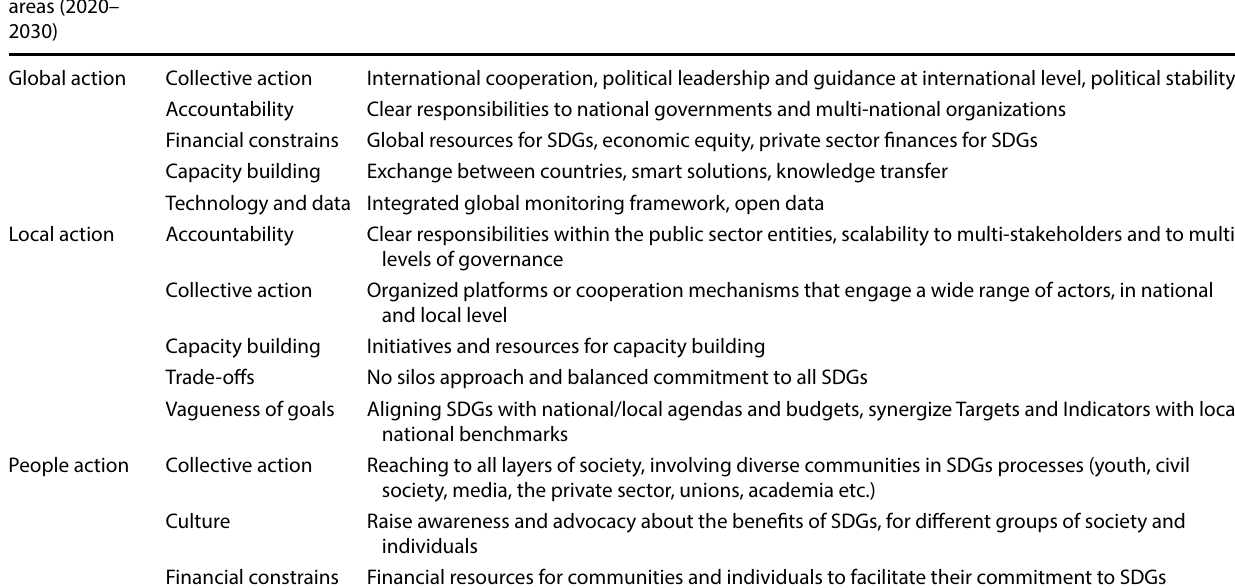
Table 1 Connections between SDG challenges and